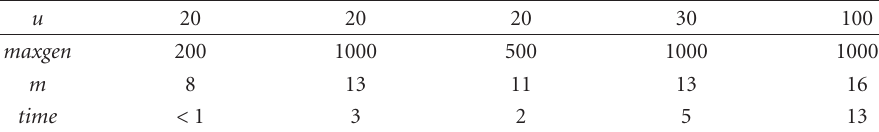
Table 4.2. Search results of 5 di ff erent parameter values for an 8-dimensional set by our approach. u